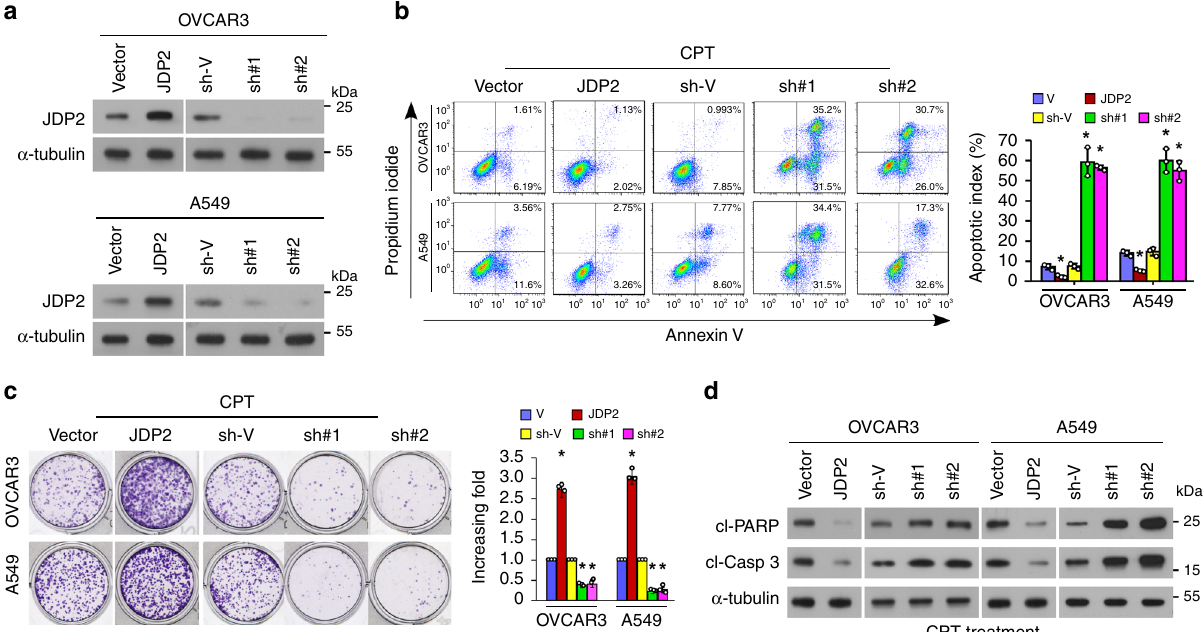
Fig. 8 JDP2 confers resistance to genotoxic stress on cancer cells in vitro. a IB analysis of JDP2 expression in the indicated cells transduced with vector, JDP2, the shRNA-vector, or JDP2 shRNA(s); α -tubulin served as the loading control. b FACS analysis of annexin-V staining (left) and quanti fi cation (right) of indicated cells treated with Vehicle or CPT (10 μ M) after 12 h. c Representative images (left) and quanti fi cation (right) of the colony number of the indicated cells treated with CPT (10 μ M), as determined by a colony-formation assay. d IB analyses of expression of cleaved-PARP1 and cleaved-caspase 3 in the CPT (10 μ M, 12 h)-treated cells. α -tubulin served as the loading control. Each error bar in panels b and c represents the mean ± SD of three independent experiments. * P < 0.05. Student ’ s two-tailed t test. Source data of Fig. 8b, c are provided as a Source Data fi le